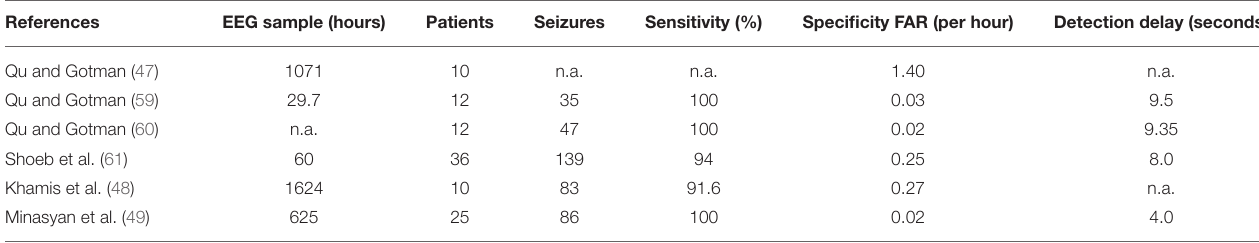
TABLE 3 | Patient specific, scalp-EEG based seizure detection algorithms tested in clinical